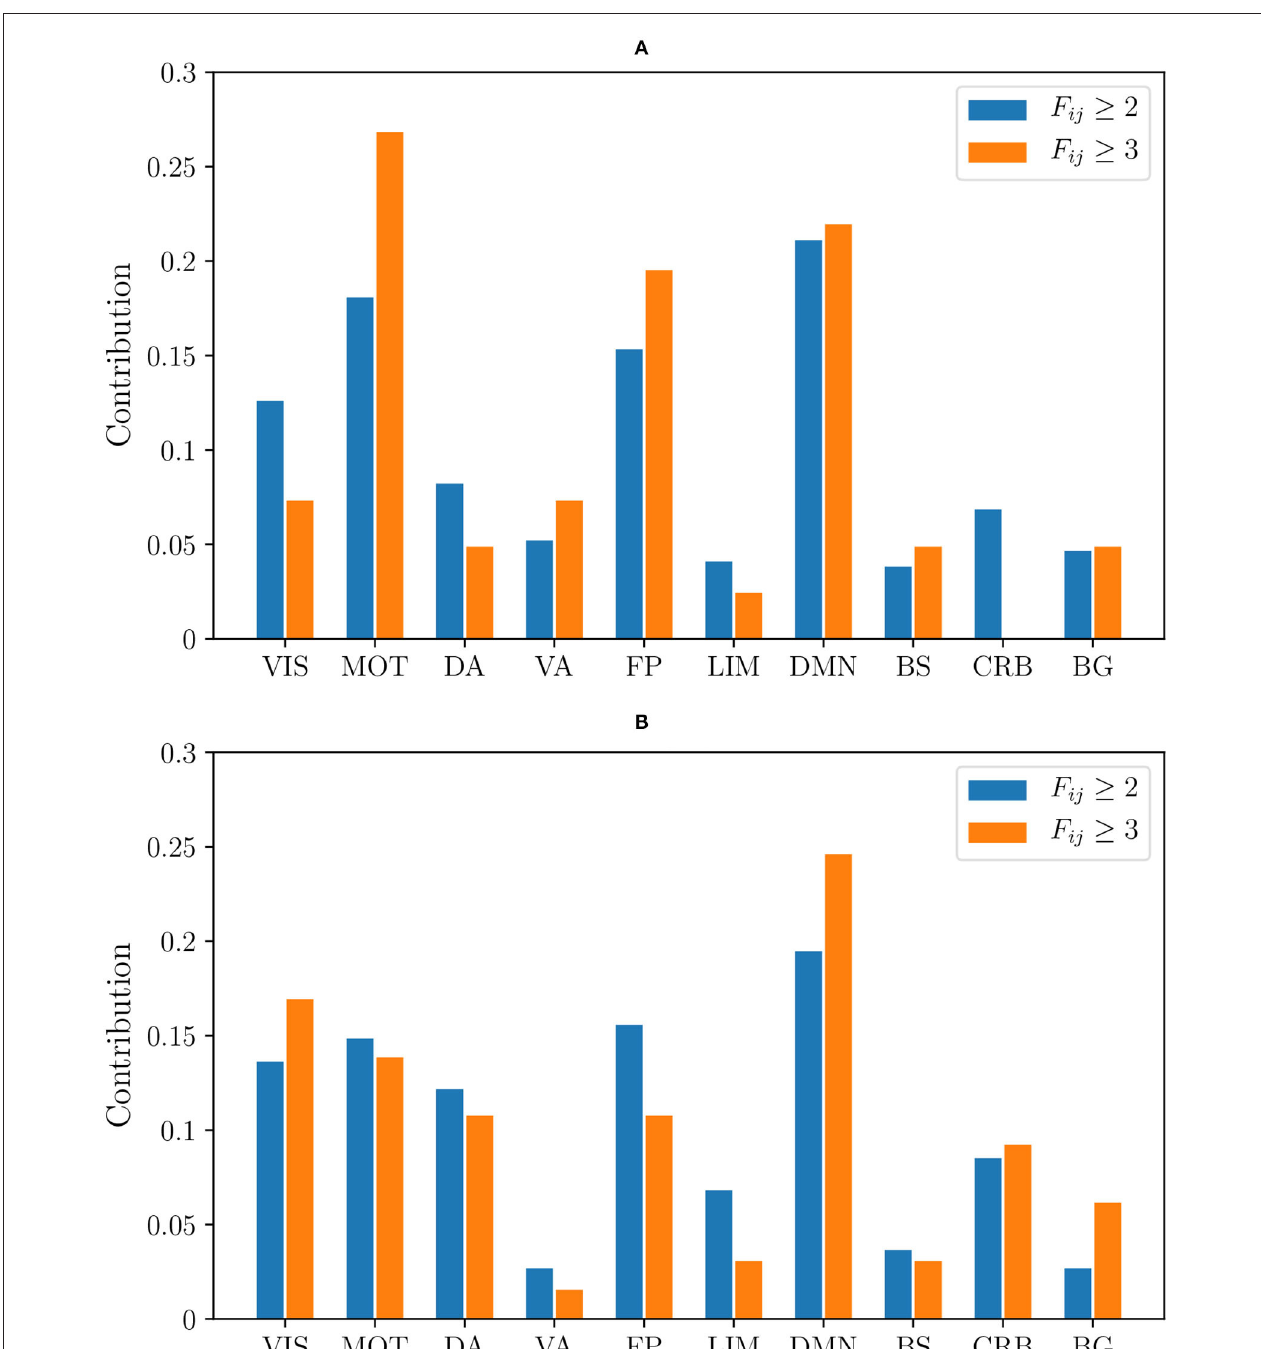
FIGURE 11 | The relative contribution of functional components to the total number of detected anomalies by thresholding frequency matrices at F ij ≥ 2 and F ij ≥ 3 corresponding to (A) the non-harmonization approach; (B) harmonization under Rigid Log-Euclidean Translation to the global mean 6 . VIS, visual network; MOT, sensorimotor network; DA, dorsal attention network; VA, ventral attention network; FP, frontoparietal network; LIM, limbic network; DMN, default mode network; BS, brain stem; CRB, cerebellum; BG, basal ganglia.